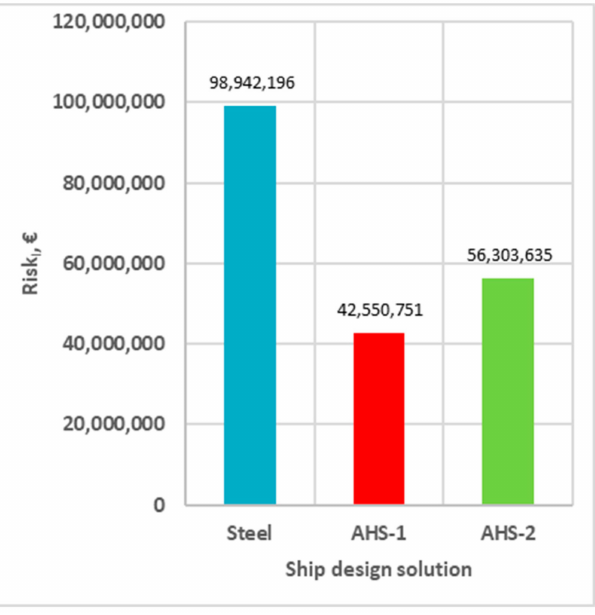
Figure 4. Risk-based design